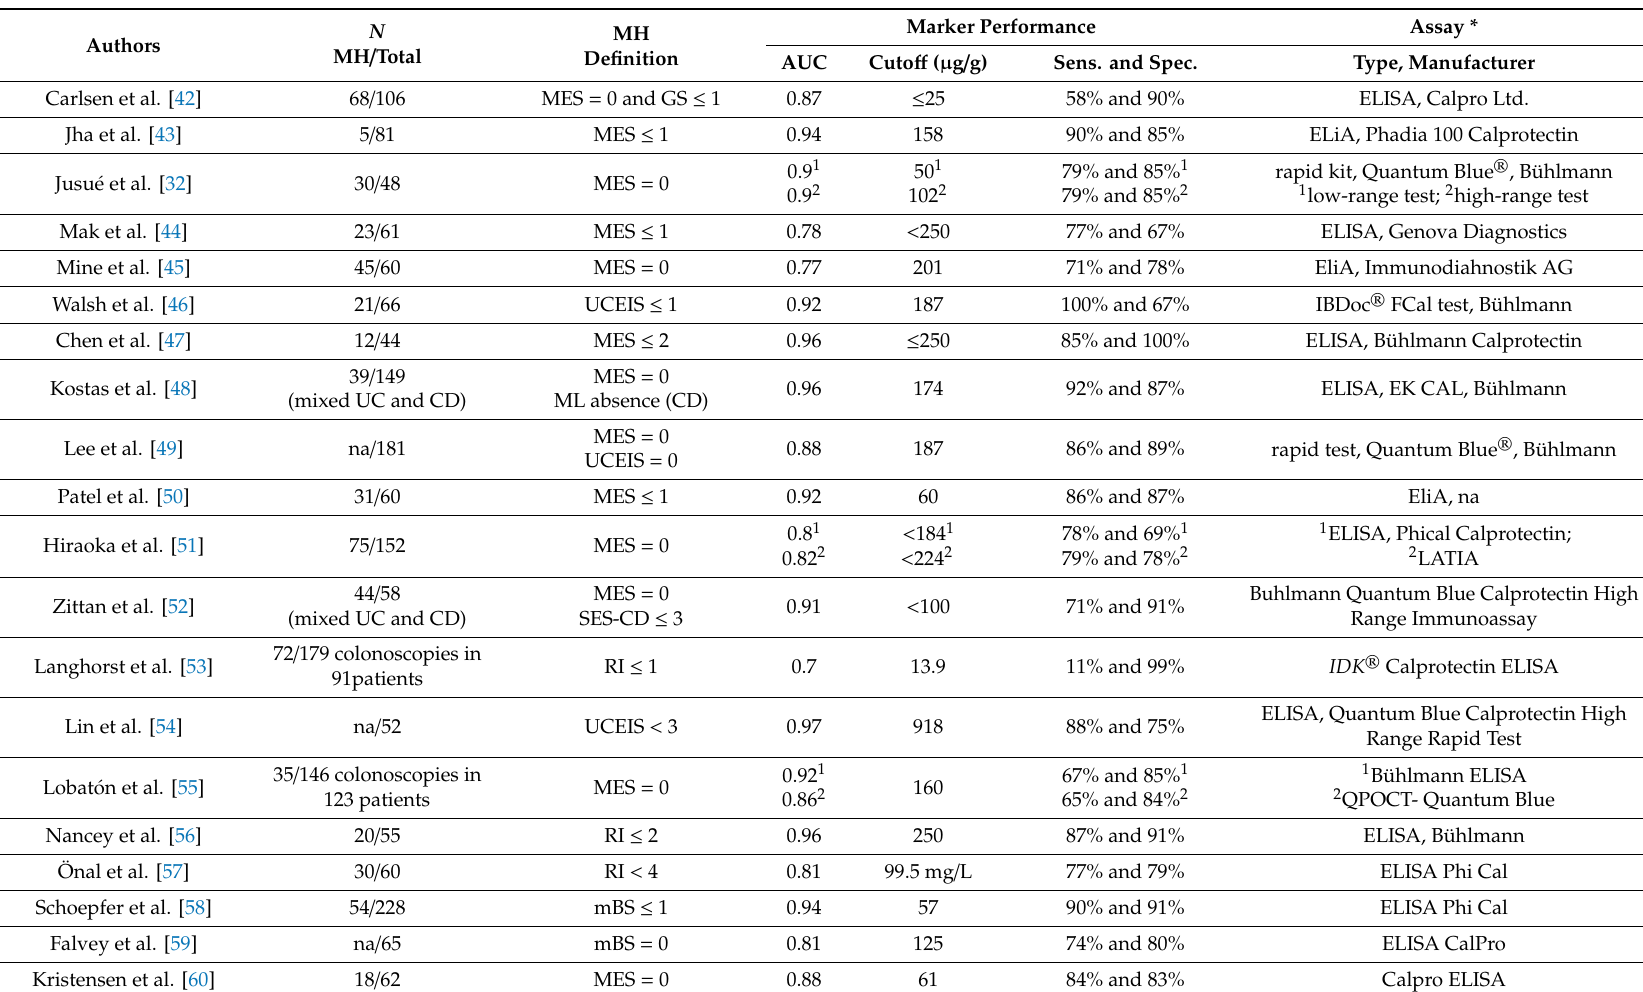
Table 2. Diagnostic performance of fecal calprotectin for MH detection for ulcerative